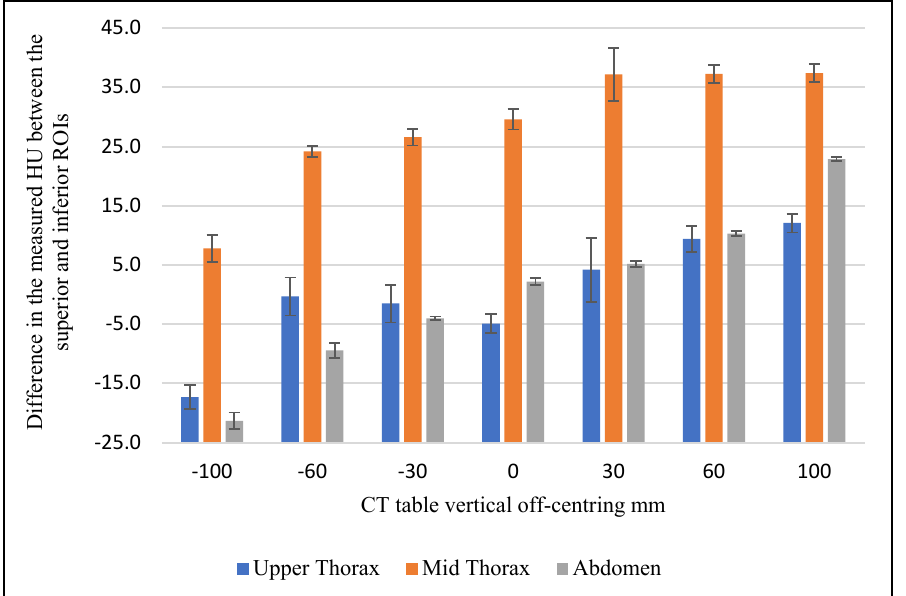
Figure 3. The difference in the mean CT number between the superior and inferior ROIs as a function of vertical off-centring for the upper thorax, mid thorax and abdominal phantom sections, at 120 kVp and 0⁰ localiser.